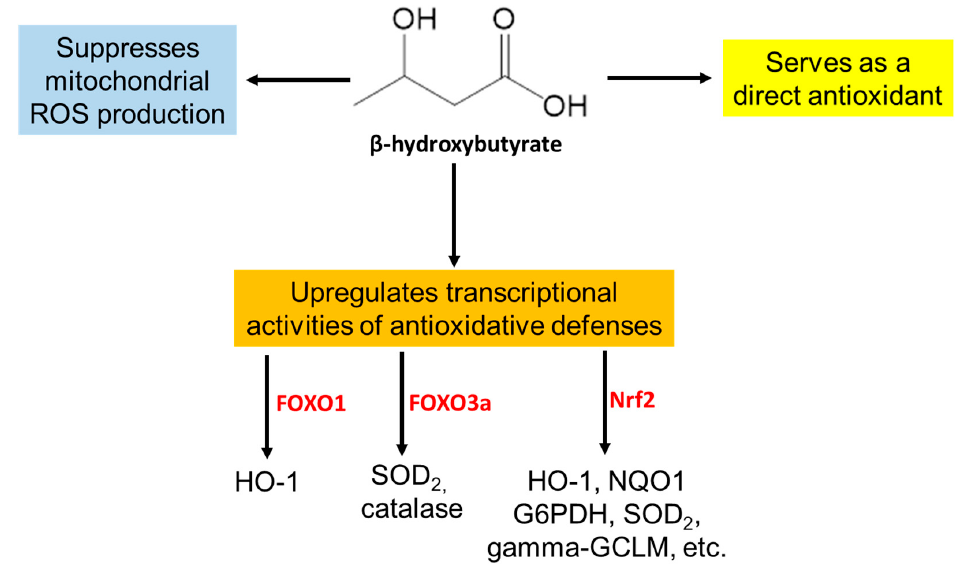
Figure 3. General properties of β -hydroxybutyrate. Shown here is that this ketone body can promote the transcriptional activities of second defense antioxidant systems, including HO-1, NQO1, G6PD, SOD2, and catalase. This figure is based on reference [20].